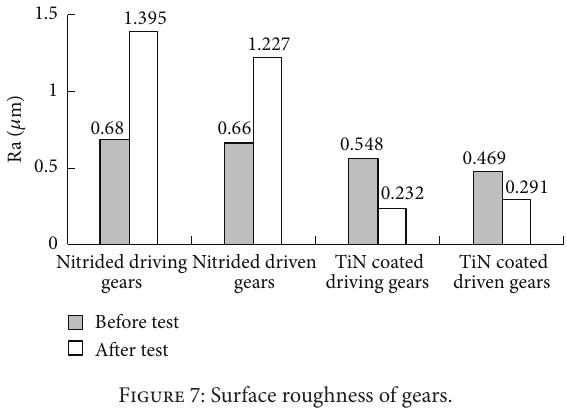
Figure 7: Surface roughness of